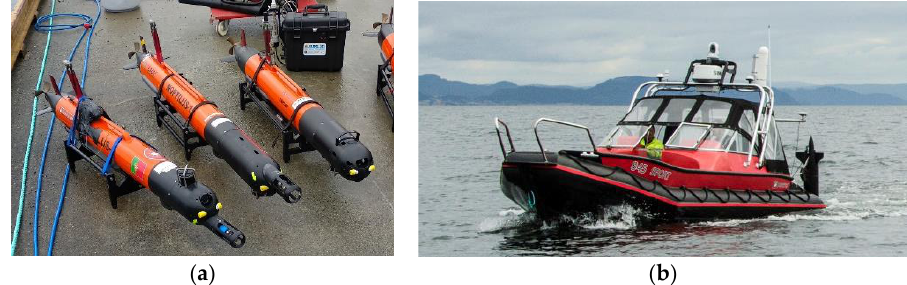
Figure 25. ( a ) AUVs Noptilus-1, Noptilus-2, and Fridtjof; ( b ) Telemetron. Table 2. Details for the vehicles used during the tests involving the MTRR.